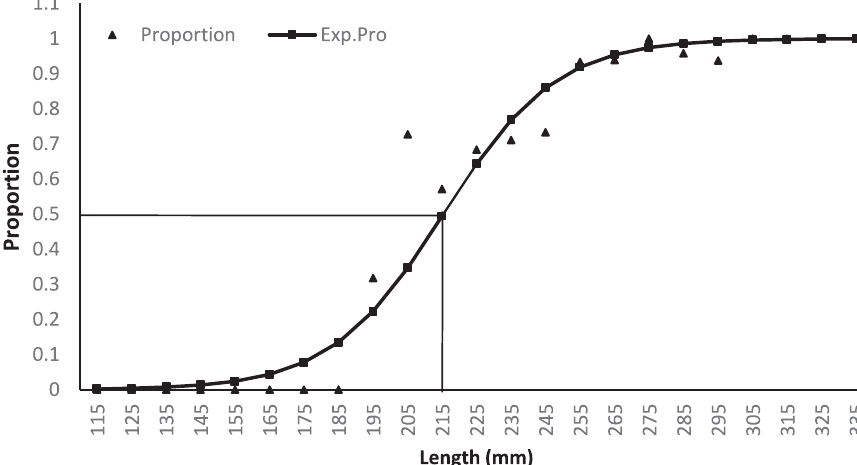
Fig. 2. Size at fi rst maturity ( L m ) among females of S. undosquamis from southeastern Arabian Sea.